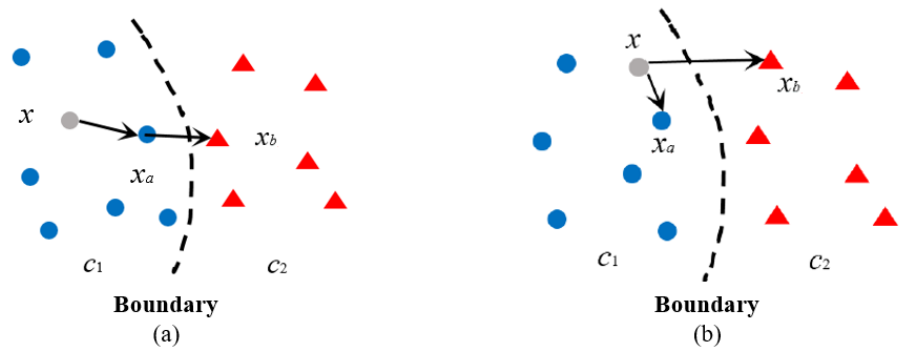
Figure 3. The first modification of DSA. ( a ) specific case. ( b )